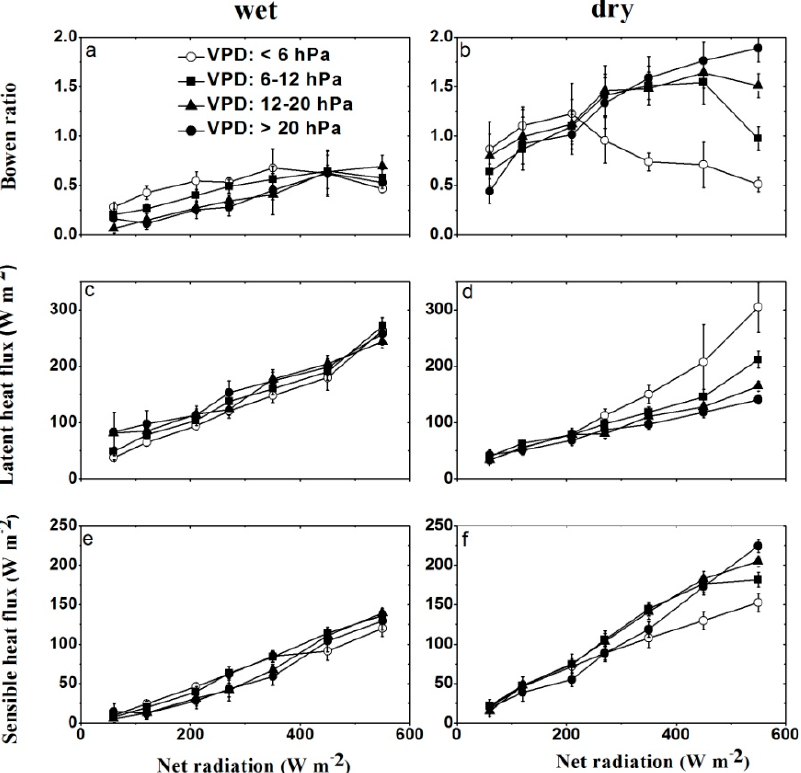
Figure 4. Effects of net radiation on ( a , b ) energy partitioning and the ( c , d ) latent heat flux and ( e , f ) sensible heat flux under drought and wet conditions at different VPD levels. Error bars represent the 95% confidence intervals.